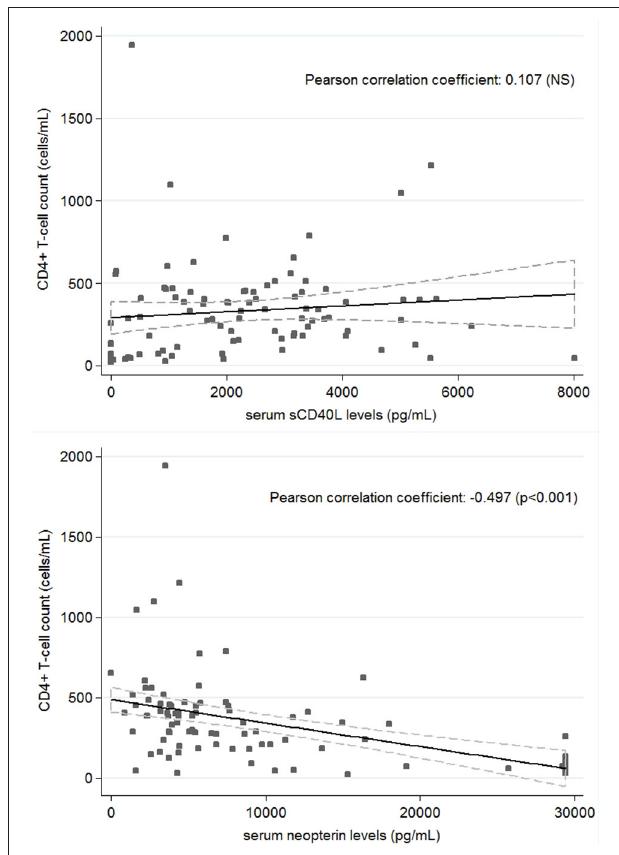
FIGURE 3 | Correlation between CD4 + T-cell count and serum sCD40L (top) and Neopterin (bottom) concentrations in all patients ( n =